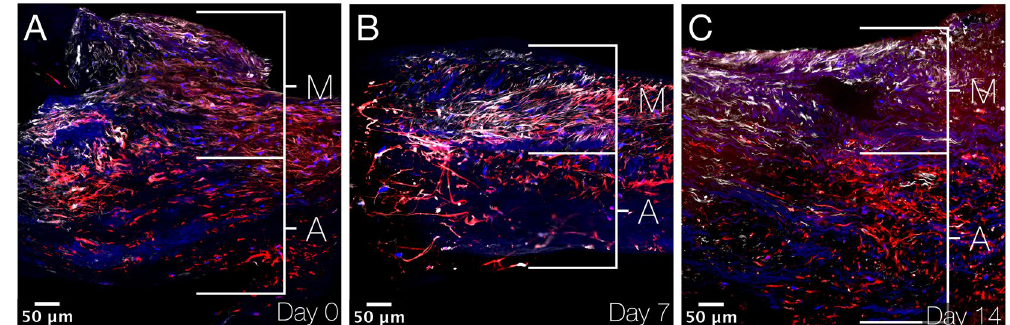
Figure 6. Immunofluorescence images showing aneurysmal aortic wall sections. ( A–C) XY stitched images at 40 × magnification using Nikon A1R confocal microscope on day 0, 7 and 14 after culturing. Smooth muscle cells are immunostained by smoothelin (white), actin (found in practically all eukaryotic cells) by phalloidin (red) and cell nuclei by DAPI (blue). Smooth muscle cells are found in the media and other cells (mainly fibroblasts) in the adventitia. M indicates media; A, adventitia and DAPI, 4 ′